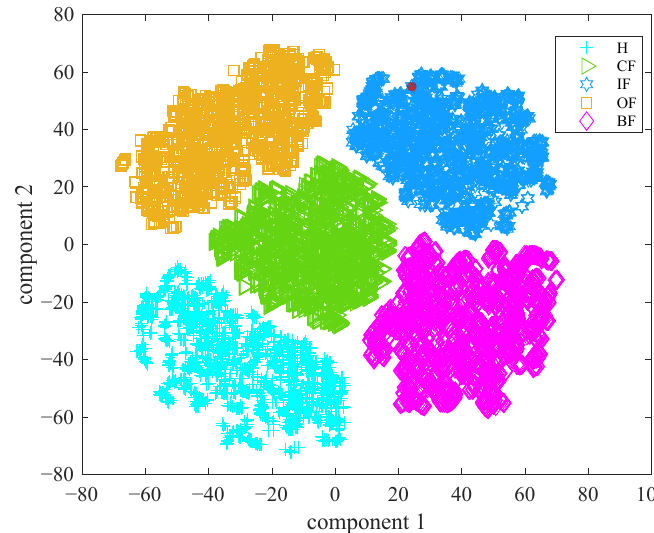
Figure 7. Fault diagnosis accuracy.